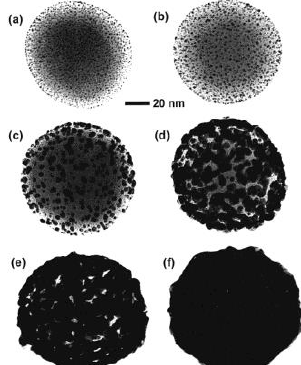
Figure 3. Growth of gold nanoshell depicted through transmission electron microscopy (TEM) images on a silica core: ( a ) Silica core decorated with gold colloid; ( b – e ) step-wise growth and coalescence of gold colloid leading to metallic gold surface layer ( f ). Reprinted with permission from Reference [30]. Copyright (1998) Elsevier.